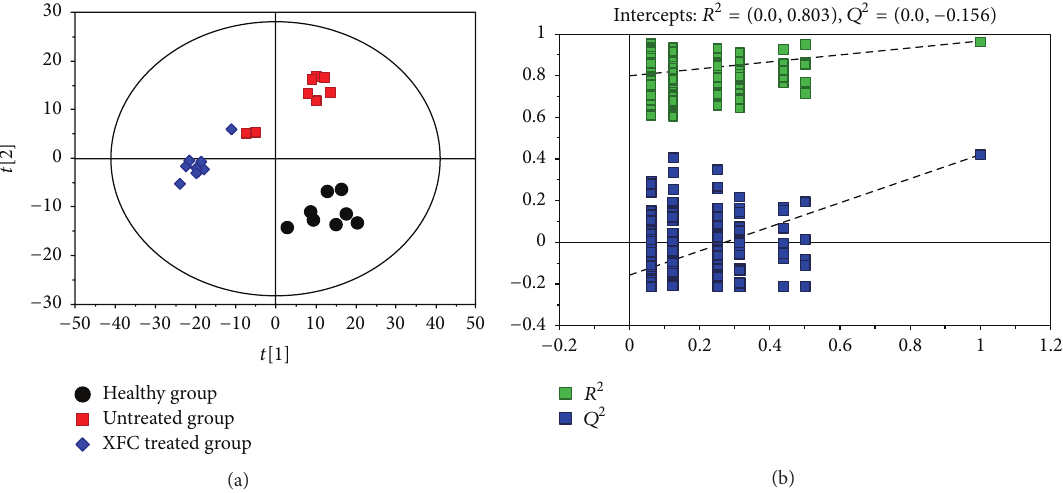
Figure 5: PLS-DA based on the adjuvant-induced arthritis date of urine. (a) shows the separation for the PLS-DA scores of healthy, untreated, and XFC treated groups. (b) represents validation of PLS-DA model (using 200 random